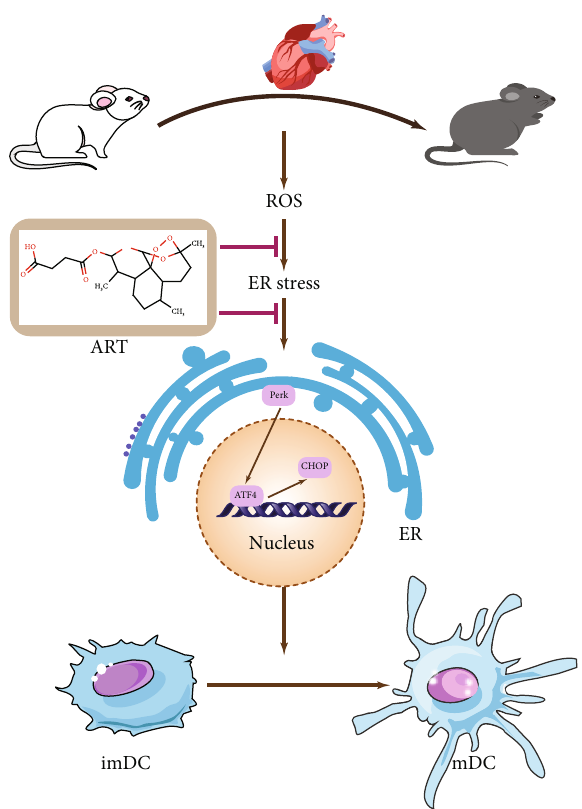
Figure 7: The mechanism of ART in BMDCs. ART reduces the generation of ROS to alleviate the endoplasmic reticulum stress and inhibits the maturation of DCs via reducing the expression of the PERK/ATF4/CHOP